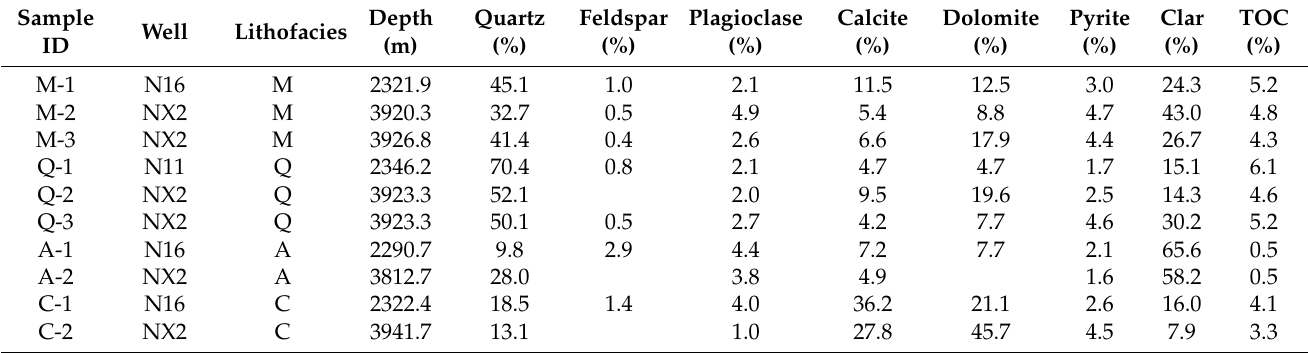
Table 1. Mineral compositions and TOC content of the Longmaxi shale.